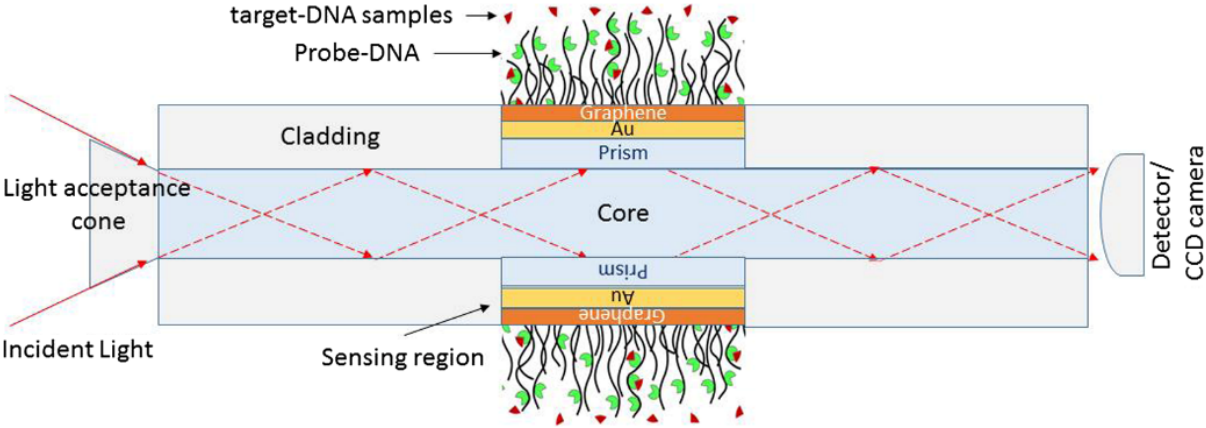
Figure 8. Illustration of an optic SPR biosensor: prism, Au, graphene, and phosphate buffer solution containing probe-DNA. Reprinted from [60] under the Creative Common CC BY licence.